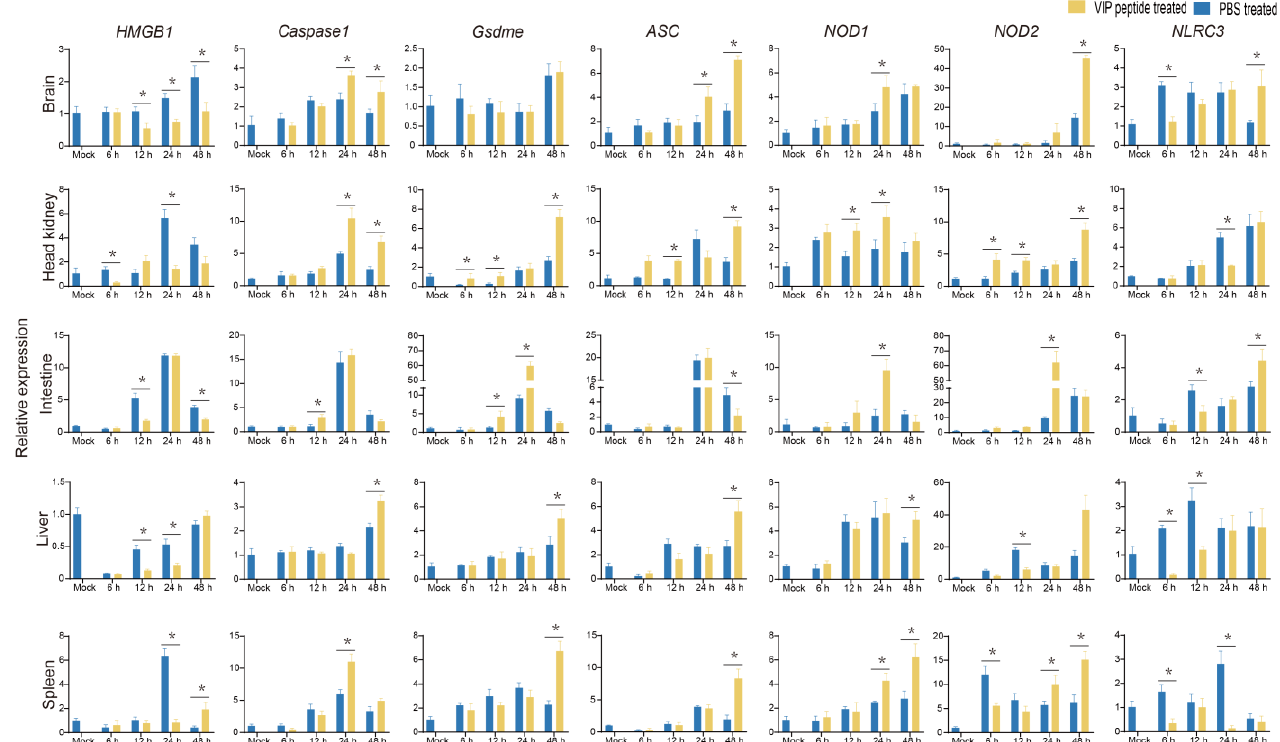
Figure 12. The relative expression of pyroptosis-related factors ( HMGB1, Caspase1, Gsdme, ASC, NOD1 , NOD2 , and NLRC3 ) at various points after S. agalactiae infection via qRT-PCR. Every value is presented as the mean and standard deviation; n = 3. The asterisks reveal the significant difference ( p < 0.05).